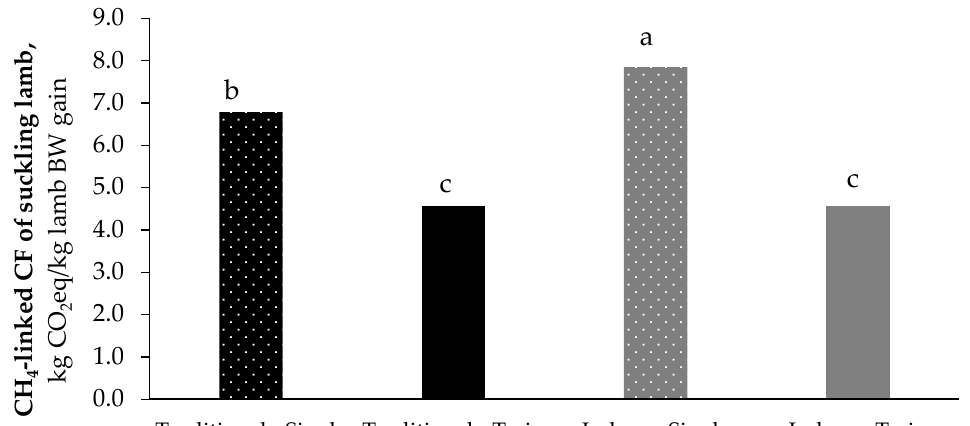
Figure 4. Effect of lamb management x type of lambing interaction on CH 4 -linked CF (expressed on kg CO 2 eq/kg lamb BW gain). a,b,c mean values with different superscripts differ ( p < 0.05) for the interaction between lamb management and type of lambing